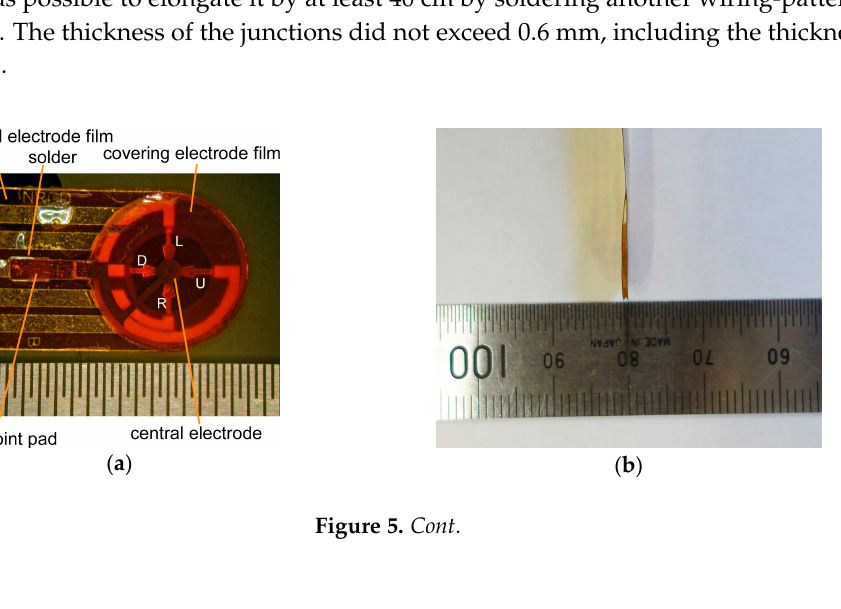
Figure 4. Testing apparatus to obtain sensor output vs. shear load.